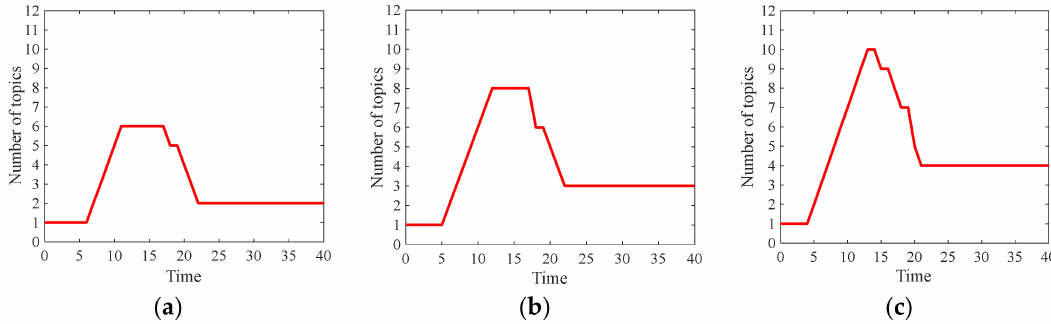
Figure 11. Changes of the number of topics under different information alienation settings. ( a ) ρ = 0.75. ( b ) ρ = 0.85. ( c ) ρ =